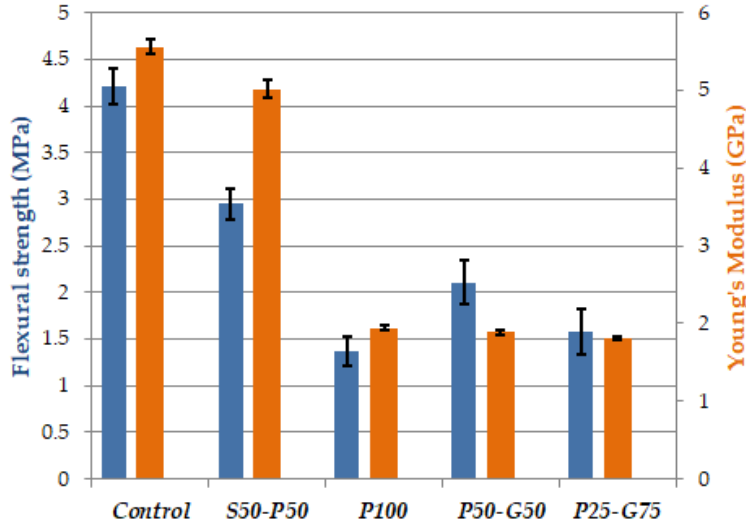
Figure 14. Four-point flexural strength results: flexural strength and Young’s modulus.